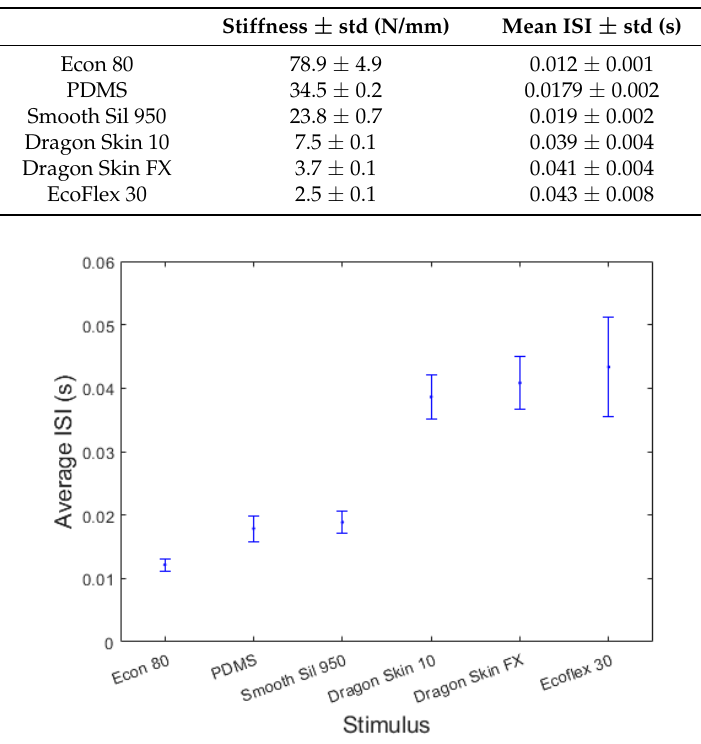
Table 2. Correspondence between the stiffness of the experimented stimuli and the inter-spike interval at the onset of the indentation as a result of the implemented neuromorphic haptic encoding strategy.